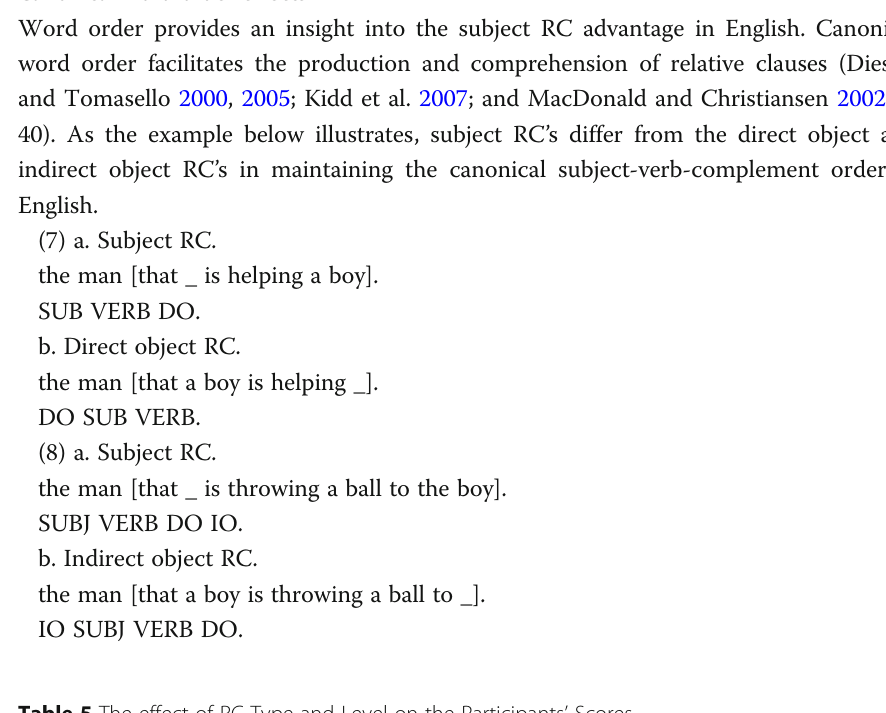
Table 5 The effect of RC Type and Level on the Participants ’ Scores Source Subject RC Type III Sum df Mean Square Wilks ’ Lambda F Sig. & Indir. Obj. RC of Squares RC type Linear. Level Linear